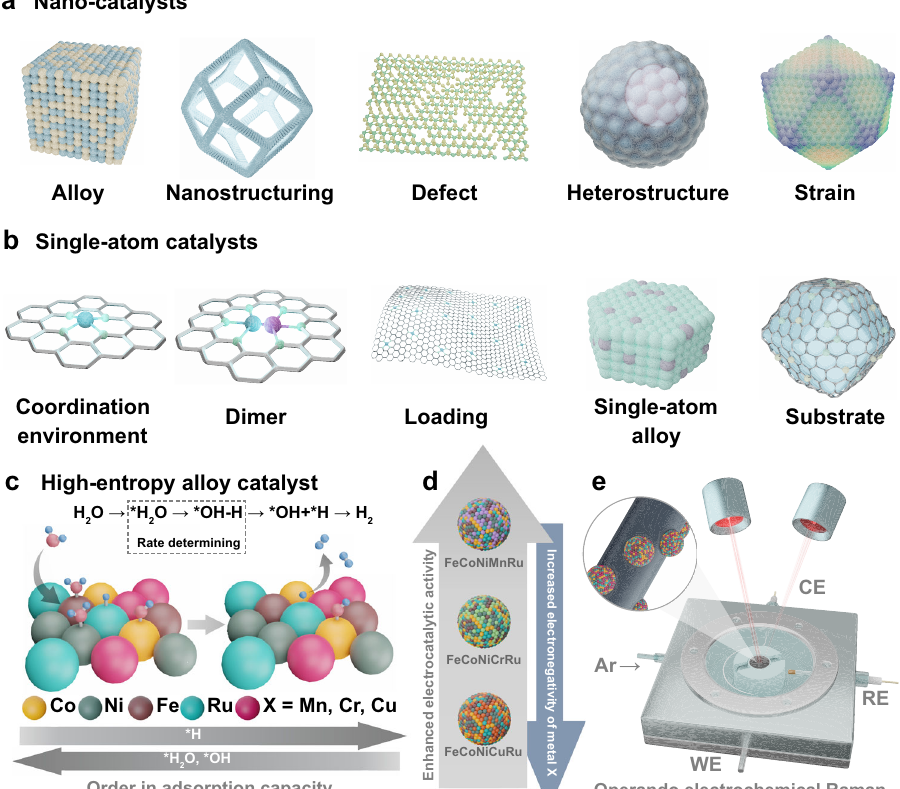
Fig. 1 Illustration of the concepts for designing nano catalysts, SACs and HEA catalysts. Designed strategies for creating active sites in ( a ) nano catalysts and ( b ) SACs. c Schematic illustration of HEA electrocatalysts with identi fi ed electronegativity-dependent preferences for active site adsorption of the intermediates OH * and H * during H 2 O dissociation and H 2 production steps. d Adjustments of the HER activities of HEA electrocatalysts by tailoring the electronegativity of the composition. e Identifying active sites of HEA for stabilization of intermediates by operando electrochemical Raman